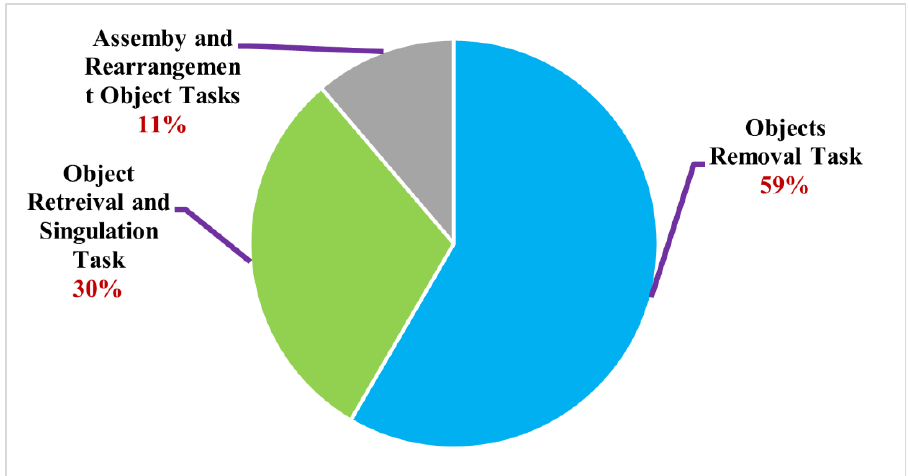
Figure 2. Numerical analysis of the final set of articles with their associated tasks.